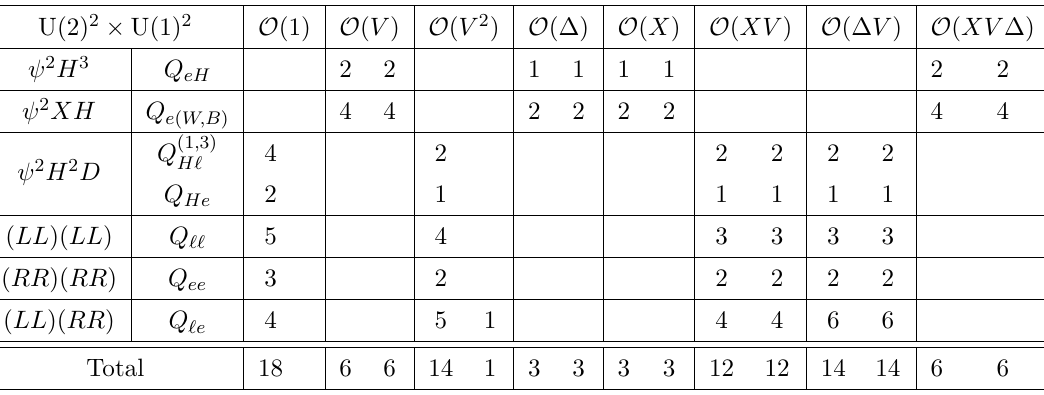
Table 11 . Counting of the pure lepton SMEFT operators (see appendix A) assuming U(2) 2 × U(1) 2 symmetry in the lepton sector. The counting is performed up to two insertions of V and one insertion of ∆ e and X ‘ spurion. Moreover, the counting is presented taking two ( X ‘ V e,‘ , ∆ e V e,‘ ) and three ( X ‘ V e,‘ ∆ e ) insertions in the spurion product. The left (right) entry in each column gives the number of CP even (odd) coefficients at the given order in spurion